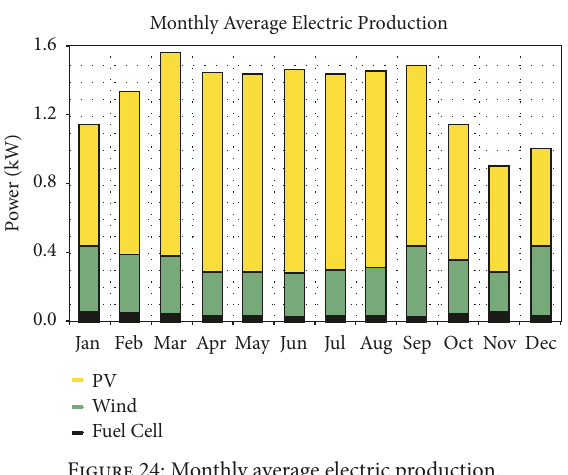
Figure 23: The DC motor power profile.